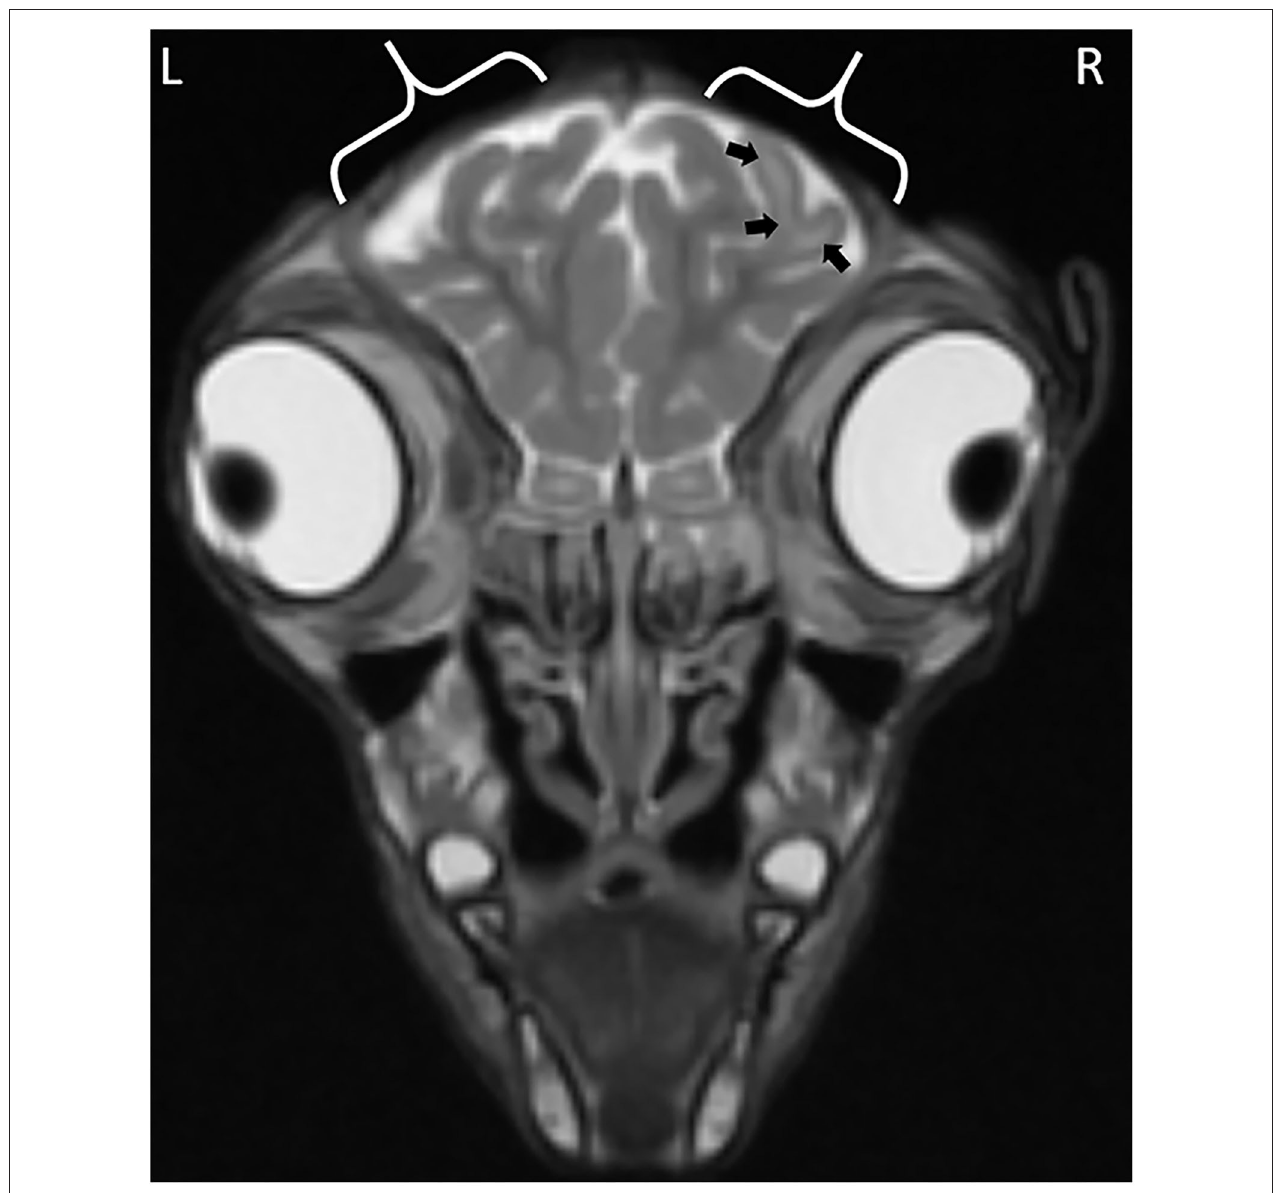
FIGURE 1 | Focal cerebral abnormalities subjacent to the right horn bud that received iron application time of 20s. The black arrows highlight gyral edema evidenced by the hyperintense (whiter) regions in the white matter of the gyrus. Calipers demark the region of skin removed at disbudding site evidenced by a gap in the midintense skin covering the